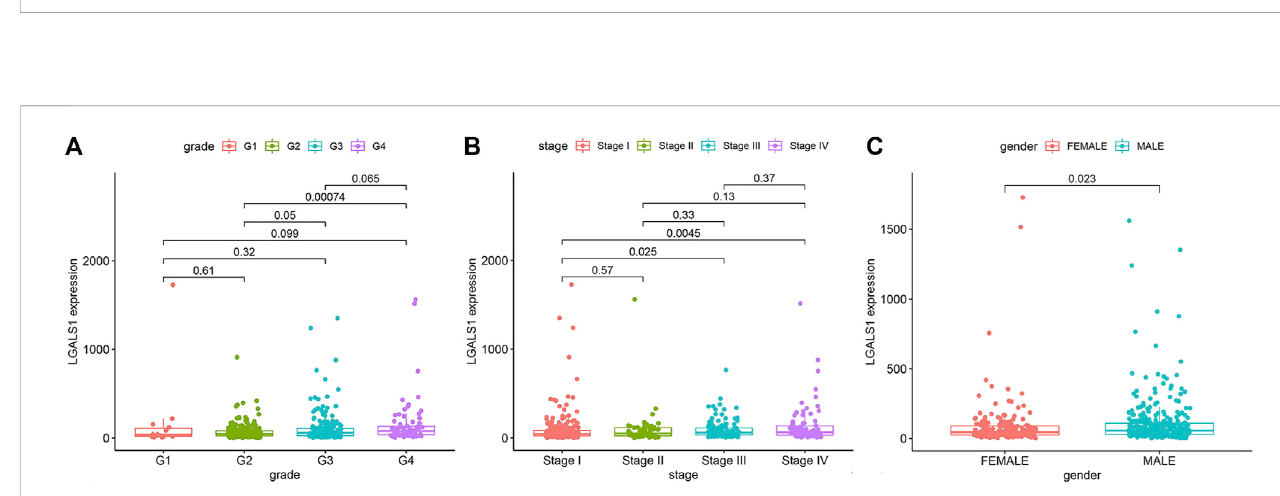
FIGURE 10 (A) ROCcurveforLGALS1inccRCCpatients. (B) ROCcurveforTIMP1inccRCCpatients. (C) UnivariateCoxregressionanalysisofLGALS1expressionand clinicopathologic characteristics. (D) multivariate Cox regression analysis of LGALS1 expression and clinicopathologic characteristics. (E) Univariate Cox regression analysis of TIMP1 expression and clinicopathologic characteristics. (F) multivariate Cox regression analysis of TIMP1 expression and clinicopathologic characteristics.